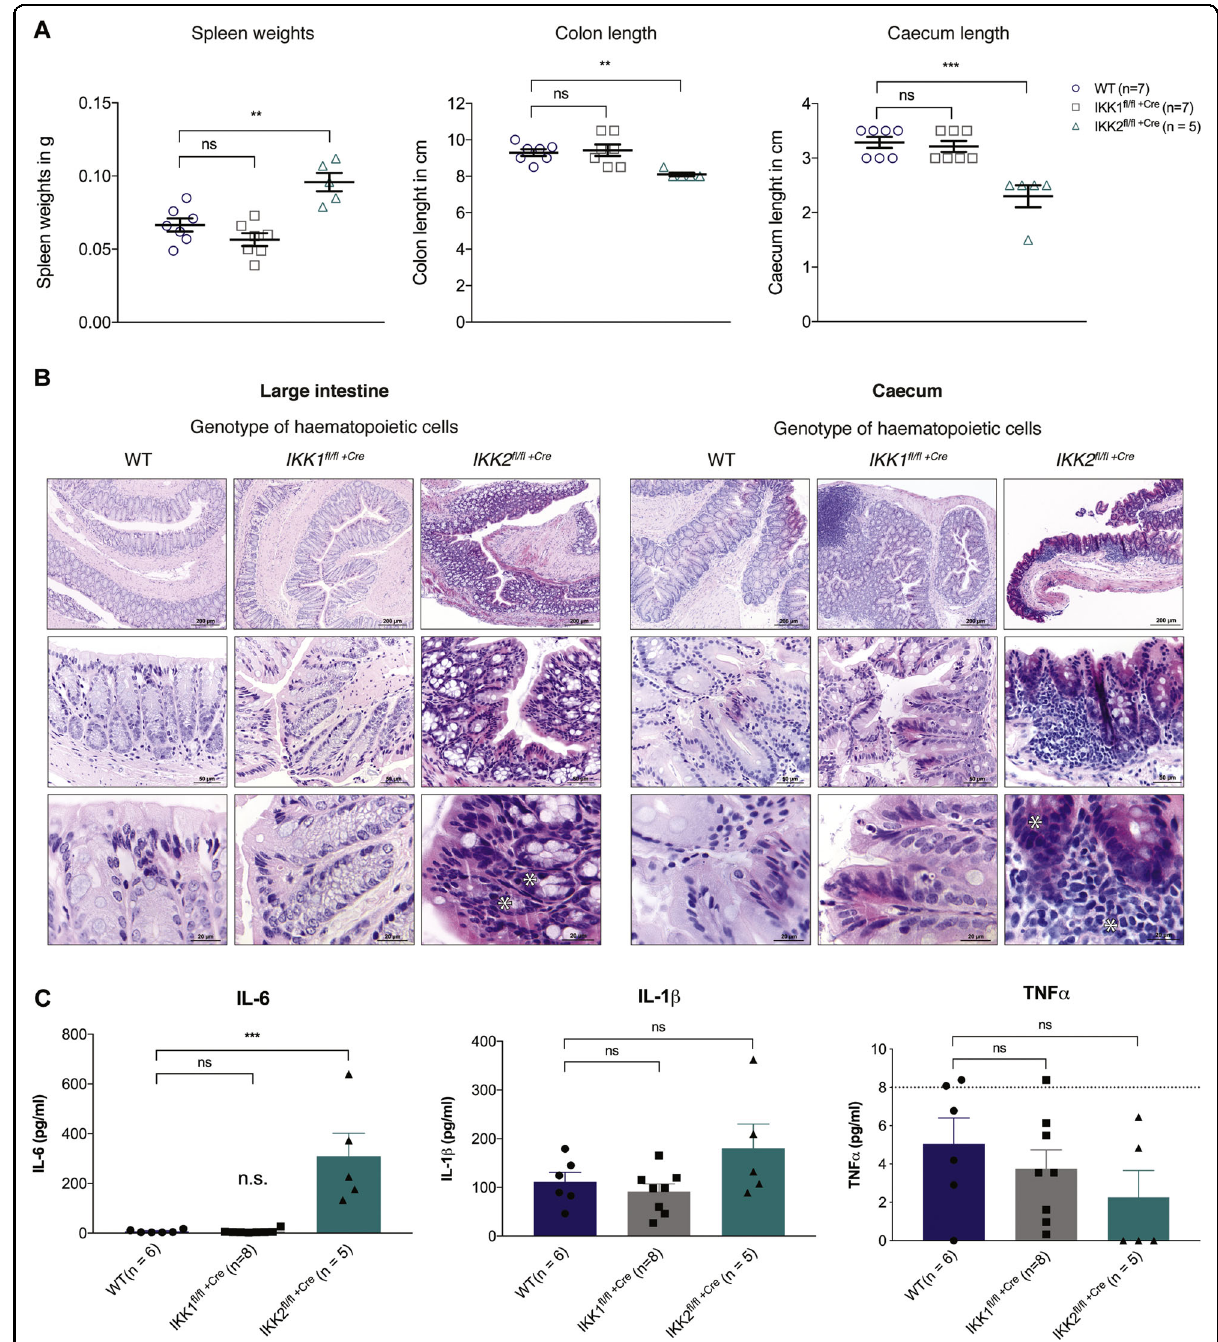
Fig. 5 Deletion of IKK2 in haematopoietic cells results in severe in fl ammation of the gastrointestinal tract and elevated serum levels of the pro-in fl ammatory cytokine interleukin-6. A Spleen weight, colon length and caecum length were measured in mice of the indicated genotypes at the experimental endpoint. Individual values, mean and SEM are shown of two independent experiments, with n = 7 mice for control and IKK1- deleted, and n = 5 mice for IKK2-deleted mice. B Colon tissue or caecum tissue, respectively, was harvested from control, IKK1- and IKK2-deleted mice at the experimental endpoint, fi xed in 10% buffered formalin, sectioned and stained with haematoxylin and eosin. Images were acquired with a microscope system at 10×, 40× and 100× (oil immersion) and evaluated microscopically. Images are of three representative mice of each genotype. Asterisks indicate in fi ltrating polymorphonuclear leucocytes present in the colon or caecum tissue of IKK2-deleted mice. C ELISA analysis of the concentrations of IL-6, IL-1 β and TNF α in the sera of mice of the indicated genotypes at the experimental endpoint. The dotted line indicates ELISA detection limit. Data are shown as mean ± SEM of two independent experiments, including individual values with n = 6 mice for control mice, n = 8 mice for IKK1 -deleted mice and n = 5 mice for IKK2-deleted mice. ns p > 0.05, ** p ≤ 0.01 and *** p ≤ 0.001 as determined by one-way ANOVA (Spleen p = 0.0002; Colon p = 0.0038; Ceacum p = 0.0001; IL-6 p = 0.0002; IL-1 β p = 0.1006; TNF α p = 0.3400) and Dunnett ’ s multiple comparison test. Of fi cial journal of the Cell Death Differentiation